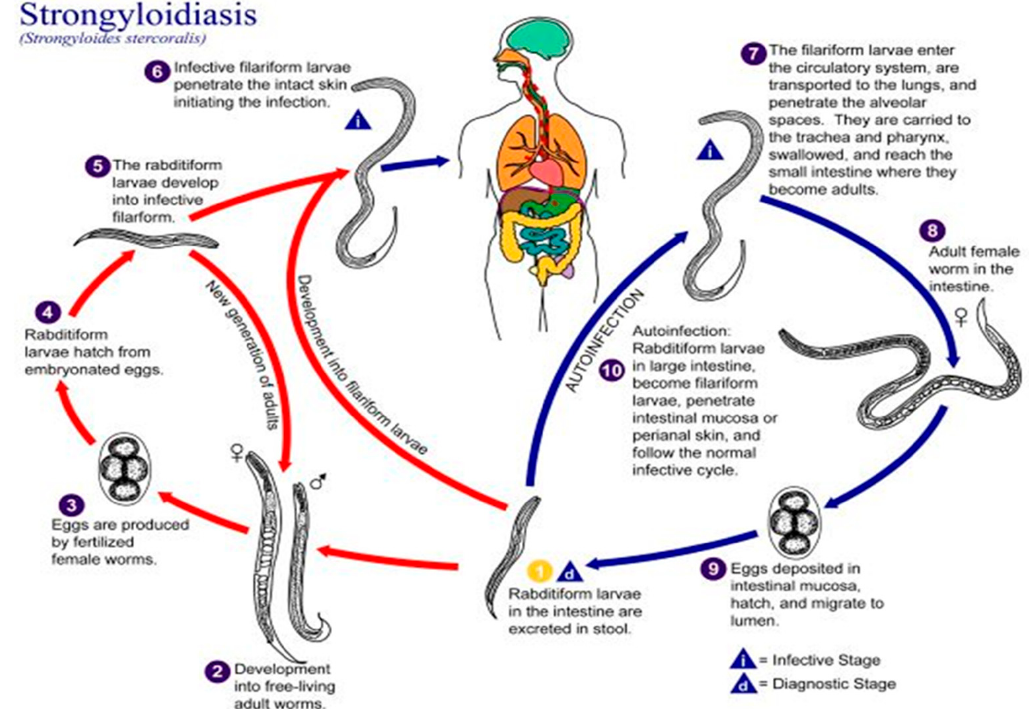
Figure 1. The life cycle of Strongyloides stercoralis , from the Centre of Disease Control (CDC). https://www.cdc.gov/parasites/strongyloides/biology.html (accessed on 10 July 2022).